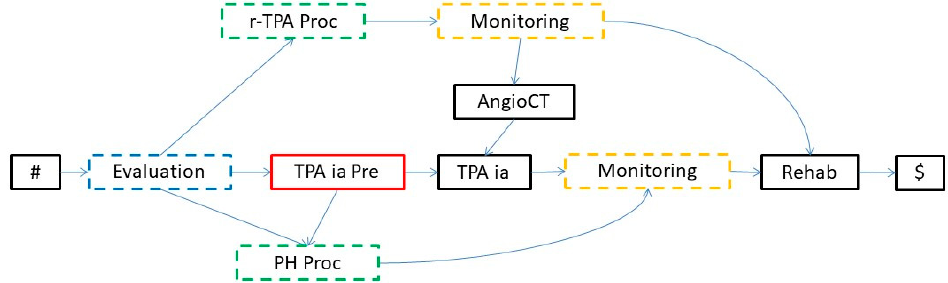
Figure 15. Process model in Figure 13 resulting from the selective merging of Monitoring.